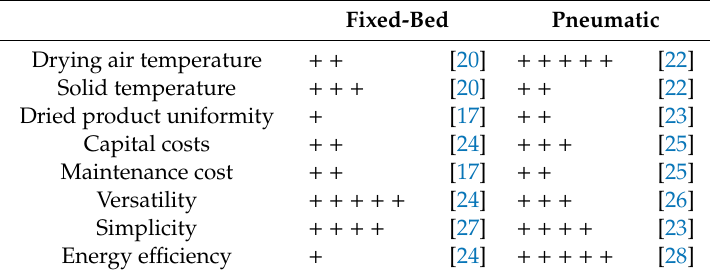
Table 1. Major characteristics of fixed-bed dryer and pneumatic dryers, where plus signs denote levels, ranging from one plus sign ( + ) to five plus signs ( + + + + +